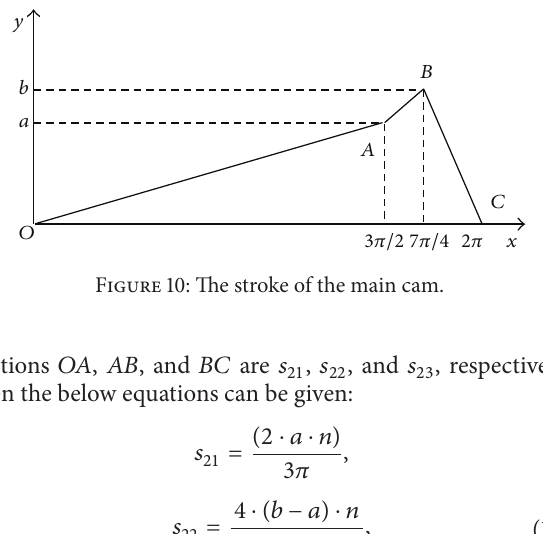
Figure 9: The principle of the main cam kinematics.